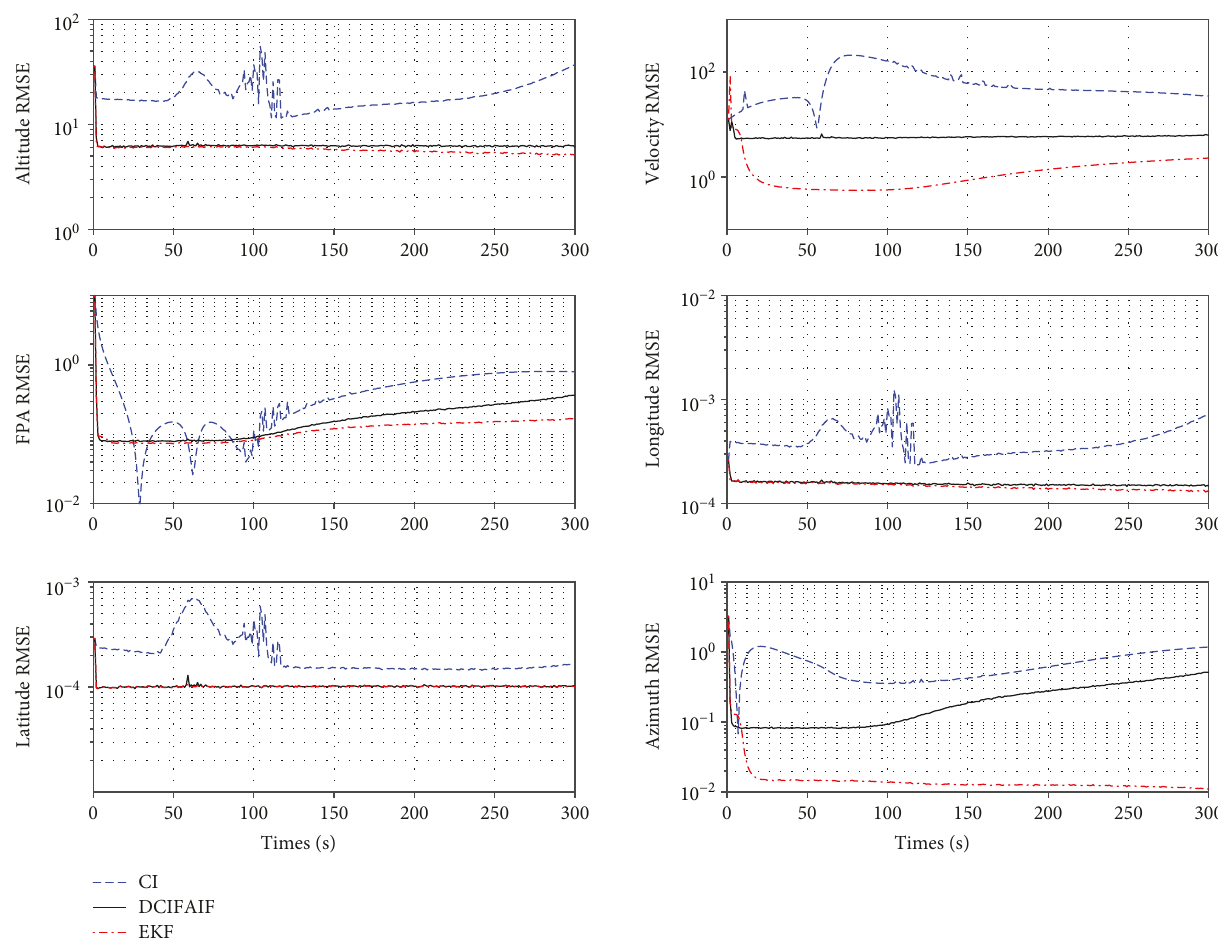
Figure 8: RMSEs for three methods during Mars